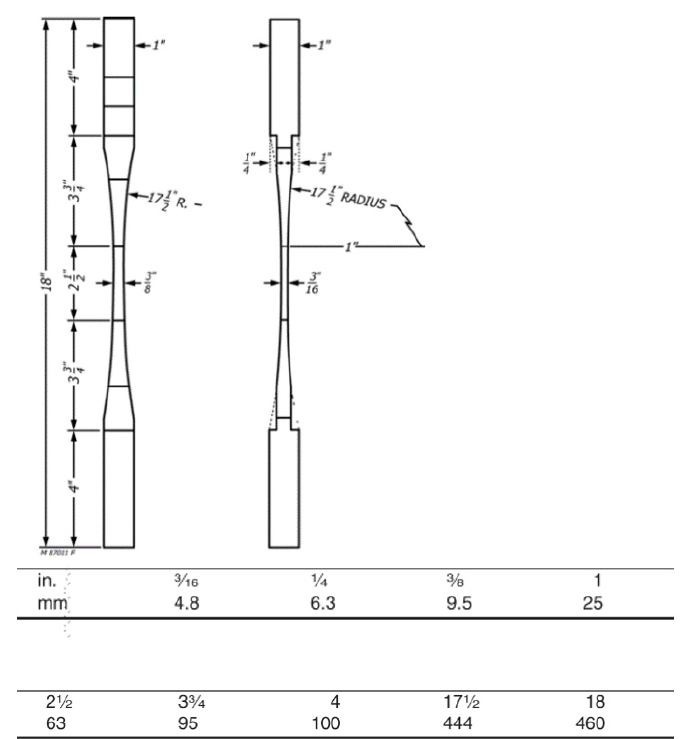
Figure 1. Tensile sample geometry as per ASTM D143 [38].